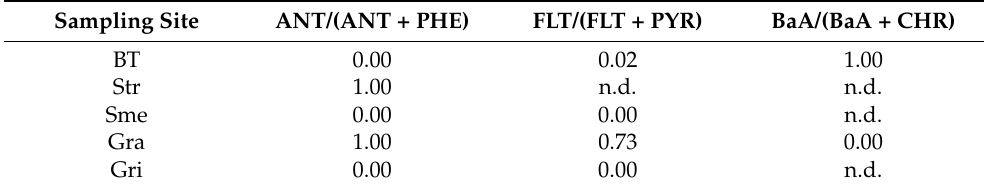
Table 4. Calculated forensic ratios based on the total measured concentrations of the 16 EPA PAHs in the five tunnel wash water samples BT, Str, Sme, Gra, and Gri. The ratios are based on the PAHs of ANT, PHE, FLT, PYR, BaA, and CHR. n.d. = not